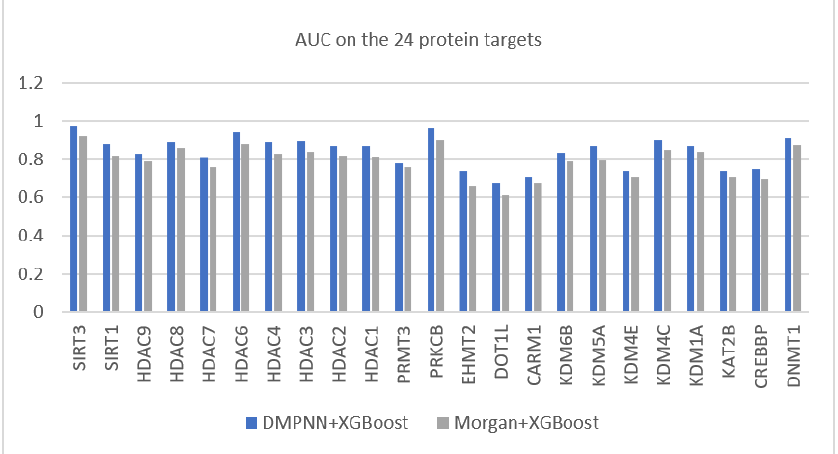
Figure 4. Performance comparison of the XGBoost models using DMPNN features and Morgan fingerprints. The horizontal axis lists the protein targets.